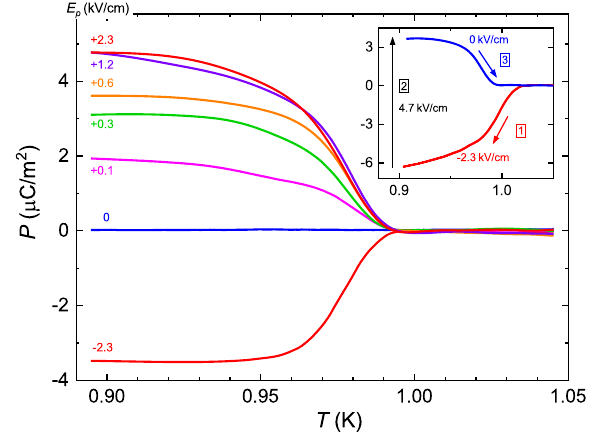
Fig. 4 Electric polarization of single crystalline PbCuTe 2 O 6 . Temperature dependence of the electric polarization of single crystalline PbCuTe 2 O 6 (sc #1(a)) as deduced from the pyrocurrent monitored upon heating. The measurements were performed for different poling fi elds ( − 2.3 to + 2.3 kV/cm), applied to the sample along the [110] direction during the preceding cooling run. For original pyrocurrent data taken at different heating rates and poling fi elds, see Supplementary Fig. 10a and Fig. 10b. The results in the inset demonstrate the switching of the polarization achieved by fi rst cooling the sample within negative fi eld (1), applying a positive fi eld for 1 min at 0.9 K (2), and fi nally reheating it without fi eld